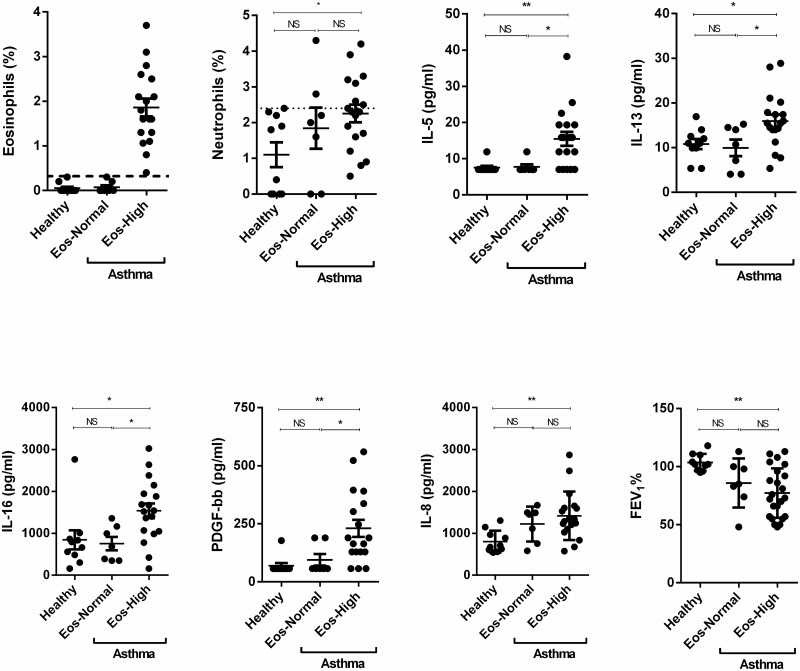
Cell and cytokine profile of eosinophil-high (Eos-High) asthma and eosinophil-normal (Eos-Normal) asthma.The upper limit of percent of eosinophils in the BAL fluid of healthy subjects was 0.3%. We separated all subjects with asthma into either eosinophil-high (eosinophils > 0.3%) and eosinophil-normal (eosinophils≤0.3%) groups. Compared to Eos-Normal asthma, Eos-High asthma had higher levels of IL-5 (p<0.05), IL-13 (p<0.05), IL-16 (p<0.05), and PDGF-bb (p<0.05), but same % neutrophils, IL-8, and FEV1. Data are expressed as means ± SEM. *P < .05, **P < .01.